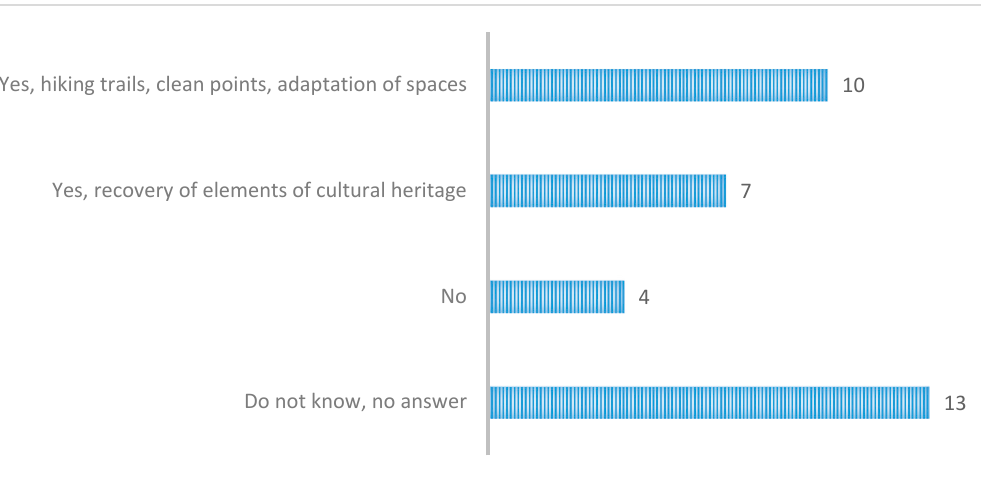
Figure 9. Do you think Proder has contributed to conserving the region's heritage and natural resources? Source: Own elaboration .